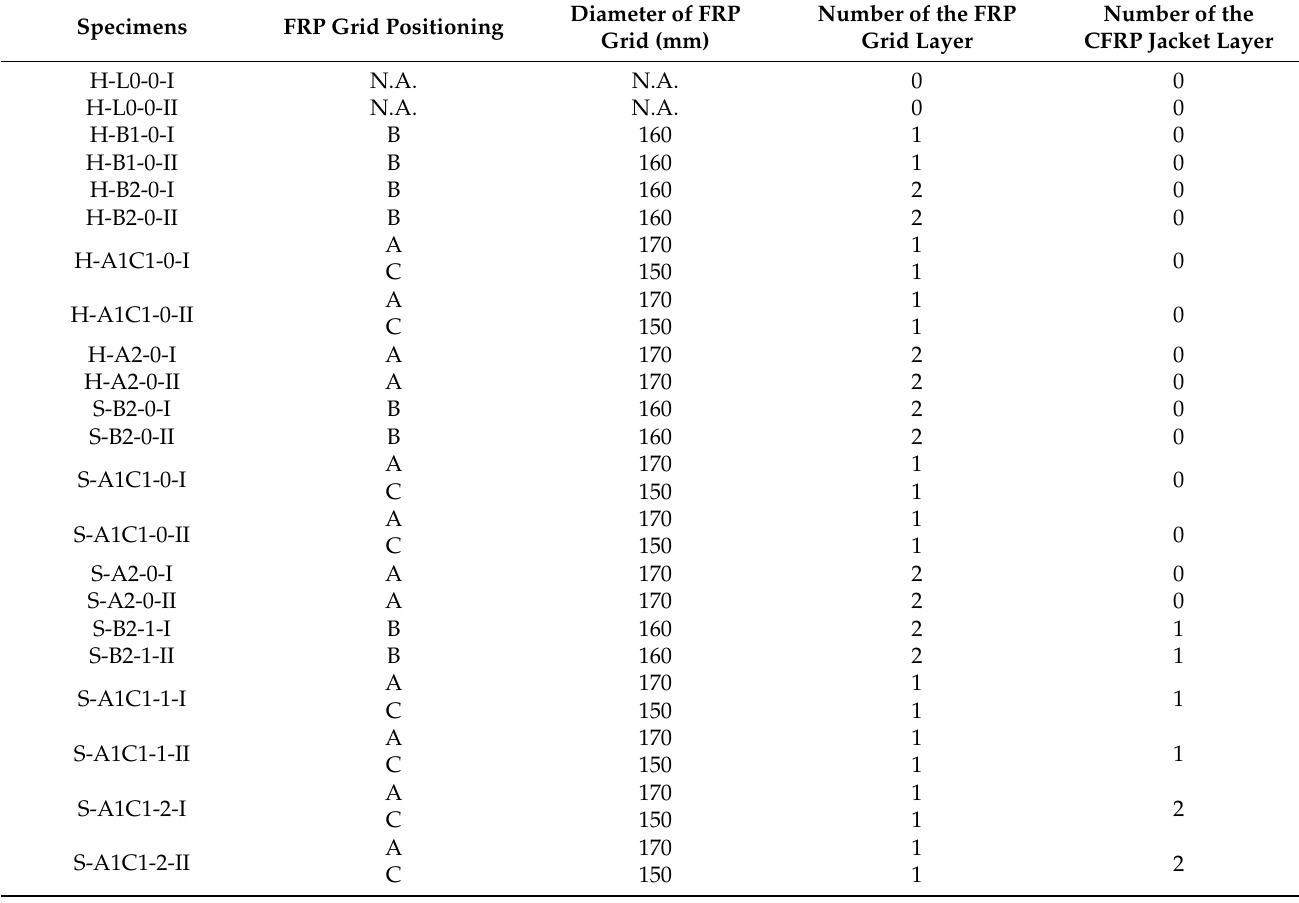
Figure 2. Dimensions of specimens (unit: mm). ( a ) Position A ( 𝑑 (cid:3034)(cid:3045)(cid:3036)(cid:3031) (cid:3404) 150 mm ); ( b ) Position B